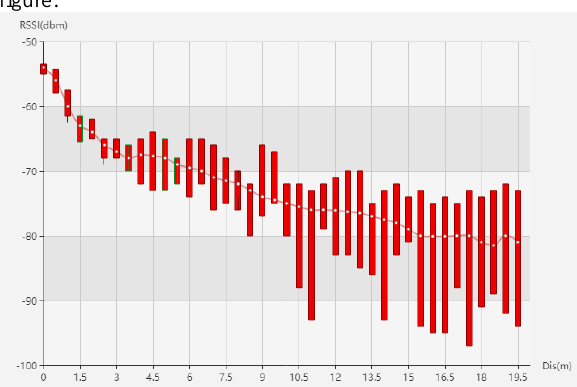
Figure 1. Relationship between the signal strength and